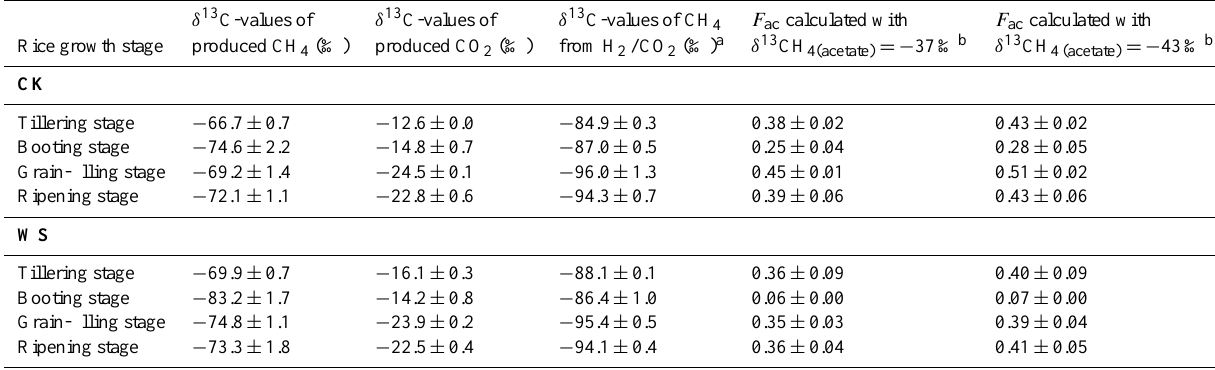
Table 6. Contribution of acetate-dependent CH 4 production ( F ac ) on rice roots at the four rice growth stages; mean ± SD, n = 3. WS: straw incorporation, CK: without straw incorporation.